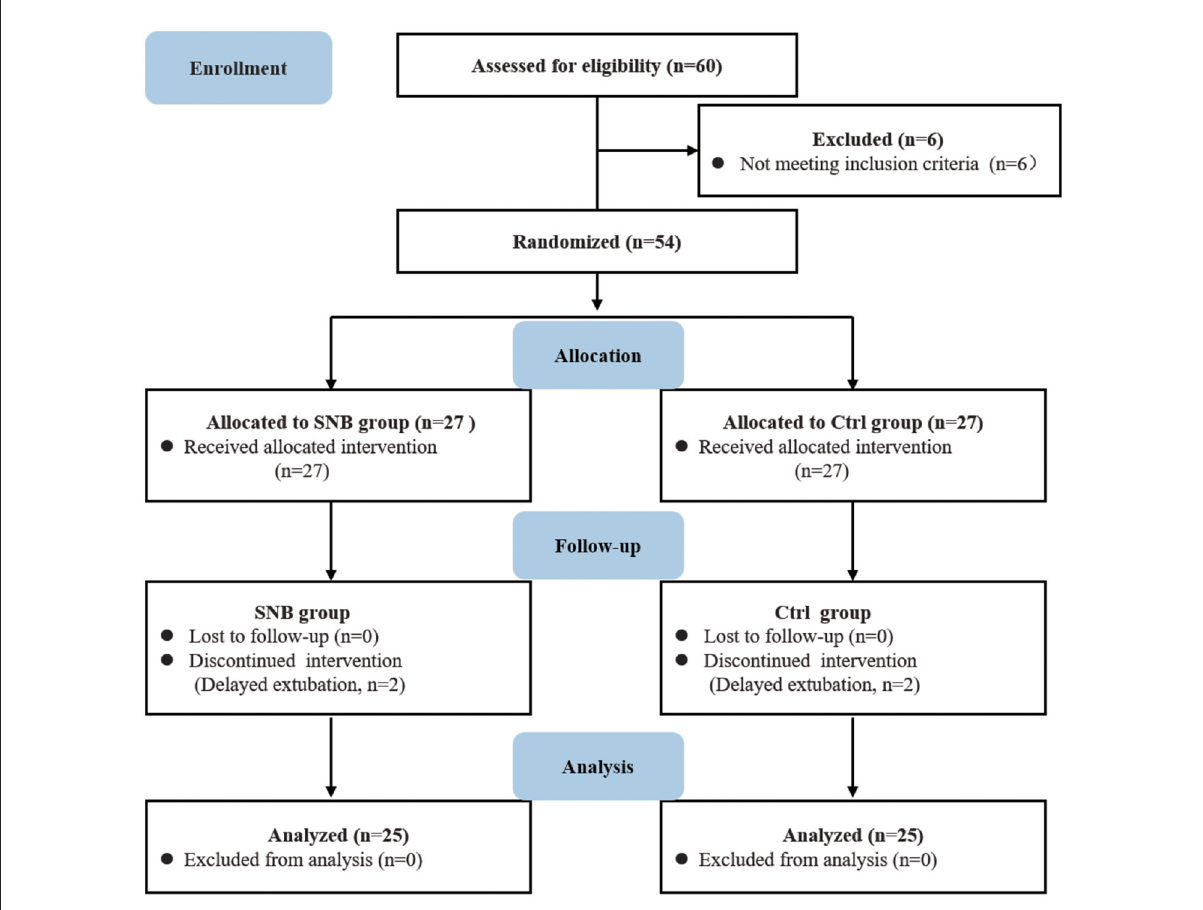
FIGURE1 CONSORT diagram showing patient recruitment and follow-up. group Ctrl, control group; group SNB, scalp nerve block group.